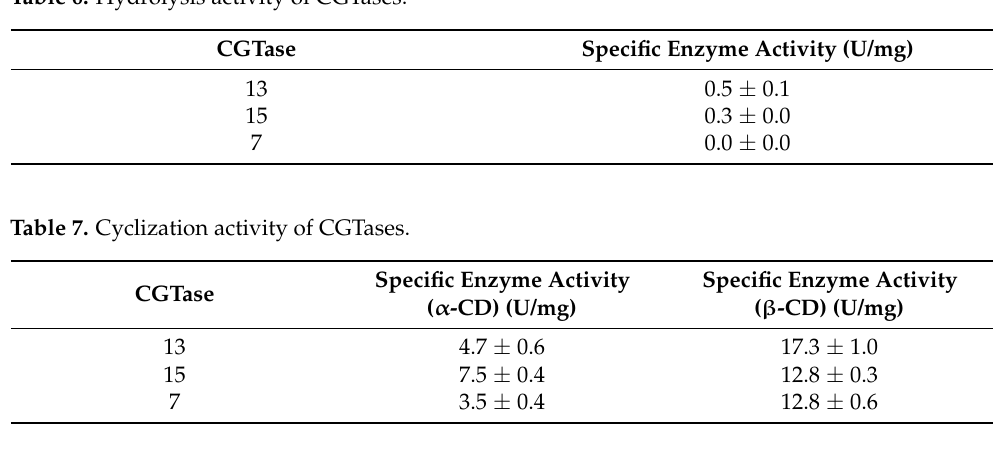
Table 6. Hydrolysis activity of CGTases.